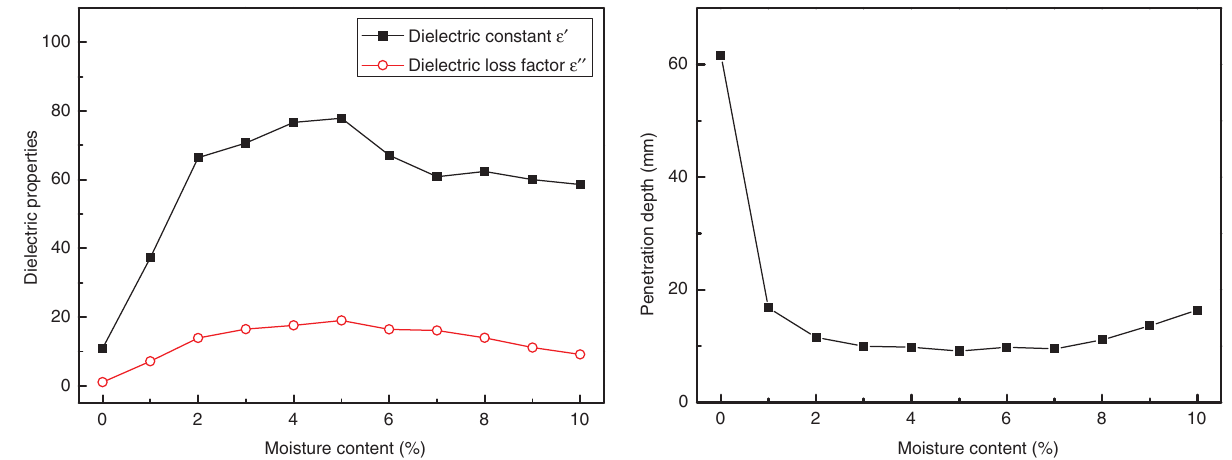
Figure 6: Variation of dielectric constant of high titanium slag with moisture content.